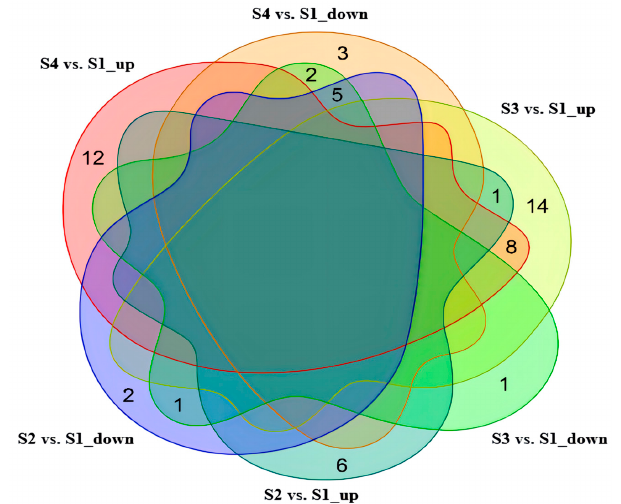
Figure 3. Expression analysis of differential metebolites from seeds of C. vietnamensis during different maturation stages.